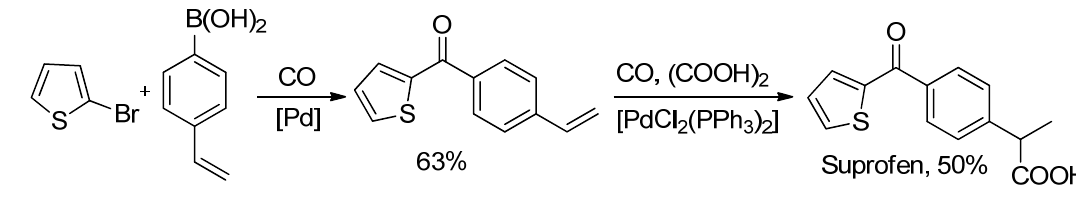
Scheme 32. Beller’s two-steps synthesis of